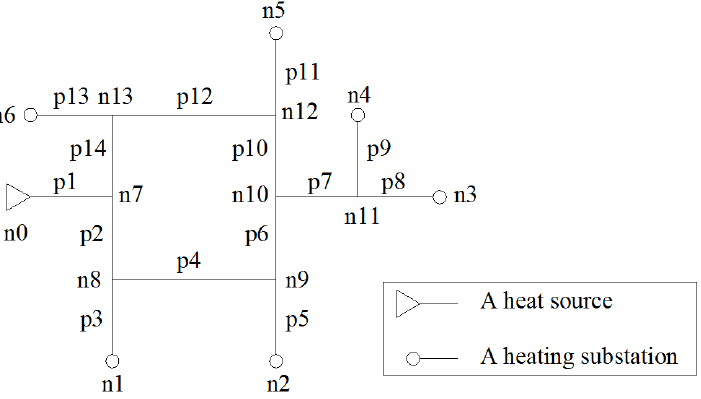
Figure 4. Schematic diagram of an example loop DHN.